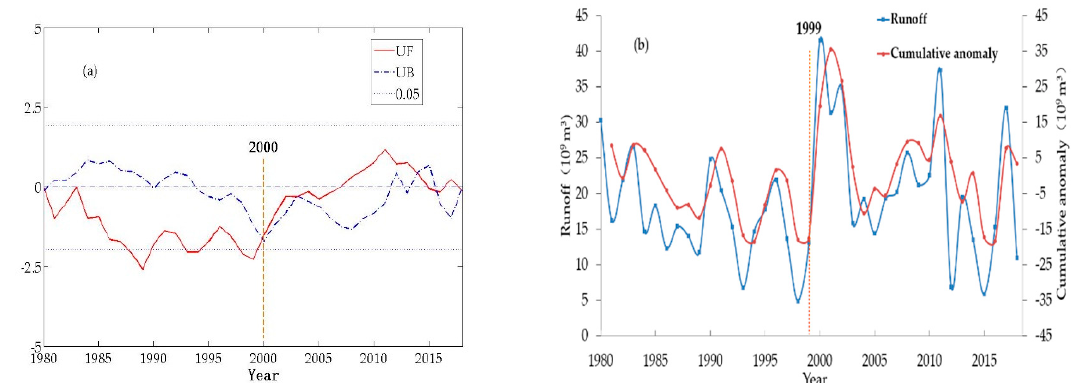
Figure 5. Results of the Mann-Kendall mutation test ( a ) and cumulative anomaly variation of annual runoff at UBON (UB) station ( b ) in Mun River.